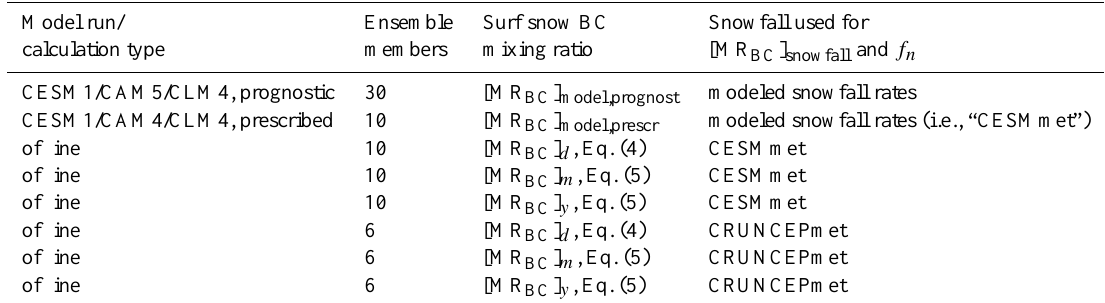
Table 1. Overview of the model runs and offline calculations compared herein. All are based on the same year 2000 aerosol and aerosol precursor emissions data set (Lamarque et al., 2010). Model run/ Ensemble Surf snow BC Snowfall used for calculation type members mixing ratio [MR BC ] snowfall and f n CESM1/CAM5/CLM4, prognostic 30 [MR BC ] model,prognost modeled snowfall rates 10 [MR BC ] model,prescr modeled snowfall rates (i.e., “CESMmet”) 10 [MR BC ] d , Eq. (4) [MR BC ] m , Eq.